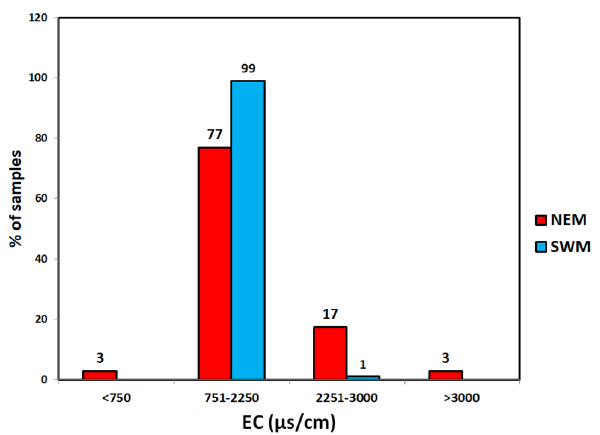
Fig. 9 EC Variations in groundwater representing different ranges with respect to season